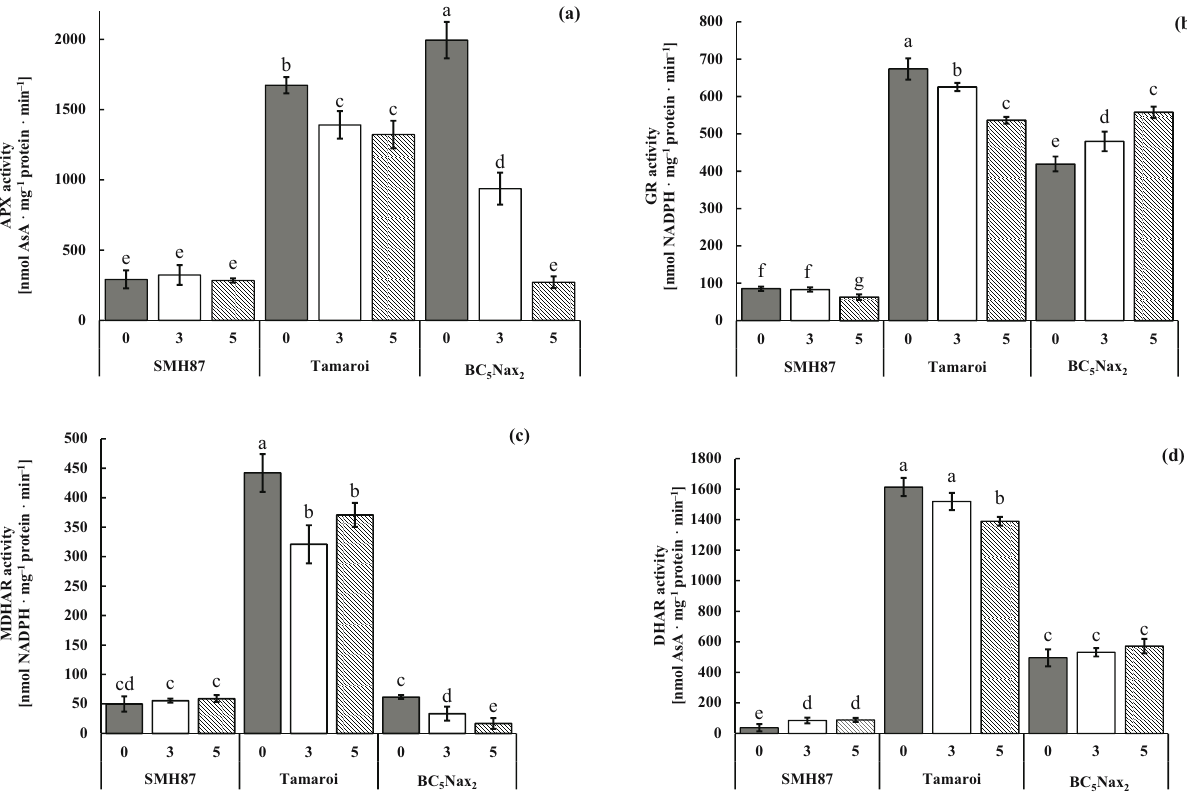
Figure 4: Activity of ascorbate – glutathione cycle enzymes in the fl ag leaves of three durum wheat genotypes grown in the soil contaminated with Cd at 0 mg ( control ) , 3 and 5 mg kg − 1 DM. Data are represented as mean ± SE in fi ve replicates. Means with di ff erent letters ( a, b, c, … ) are signi fi cantly di ff erent at P < 0.05 using the Duncan multiple range